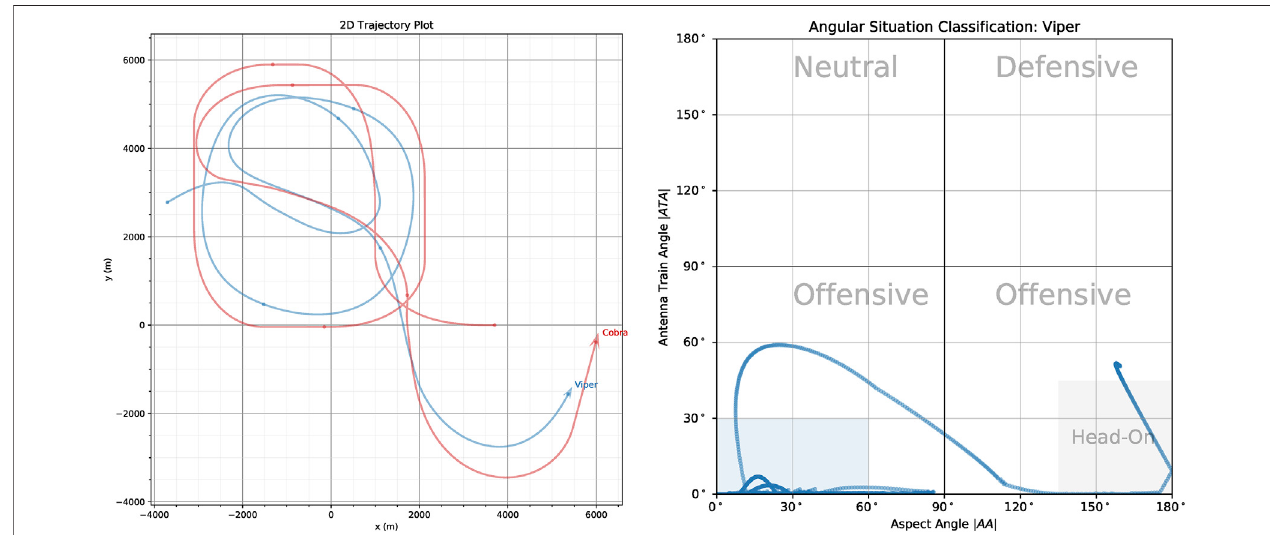
FIGURE 3 | (Left) ACE0 generated trajectories of Viper (Blue UAV) and Cobra (Red UAV) in 2D-space. (Right) The angular situation of Viper relative to Cobra in orientation space where the x -axis plots the aspect angle | AA | against the antenna train angle | ATA | on the y